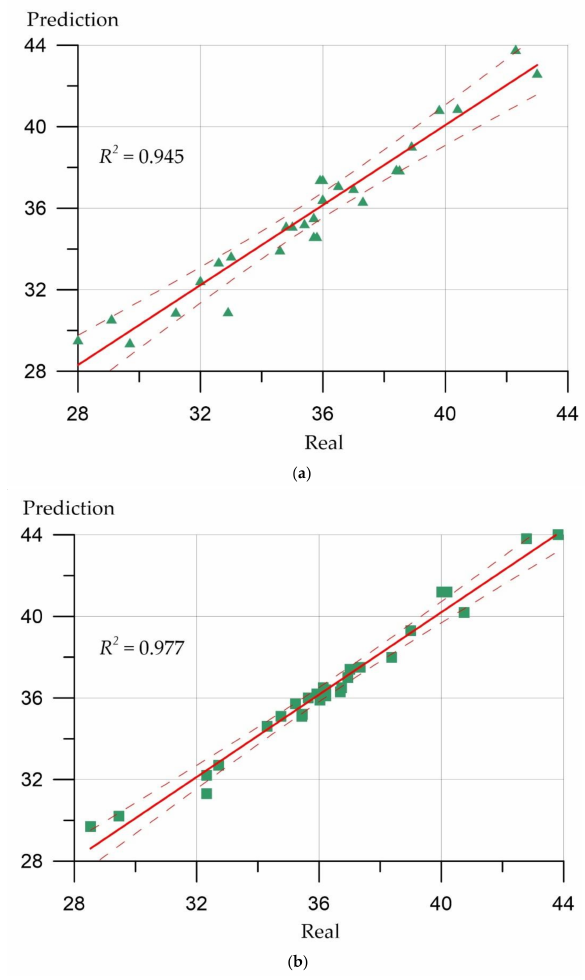
Figure 8. Correlation between real values of prismatic compressive strength (MPa) and calculated values: ( a ) Deep neural network; ( b ) ensemble of regression trees.